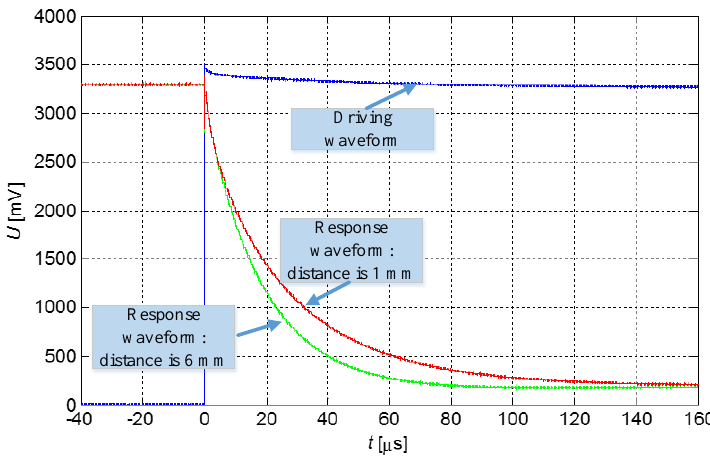
Figure 3. Driving and response waveforms of the sensing head.